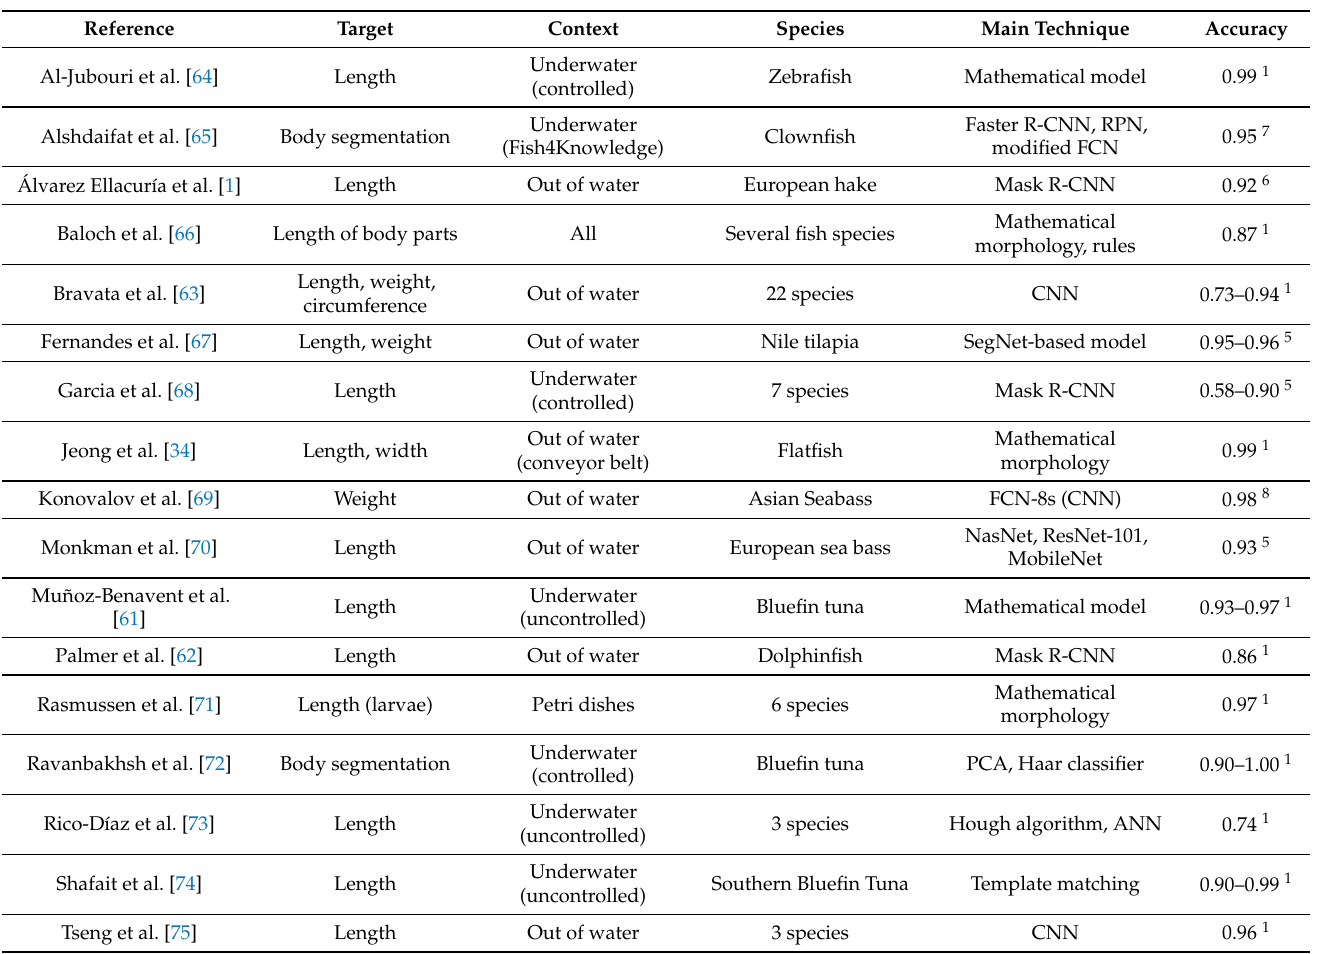
Table 4. List of articles dealing with measuring